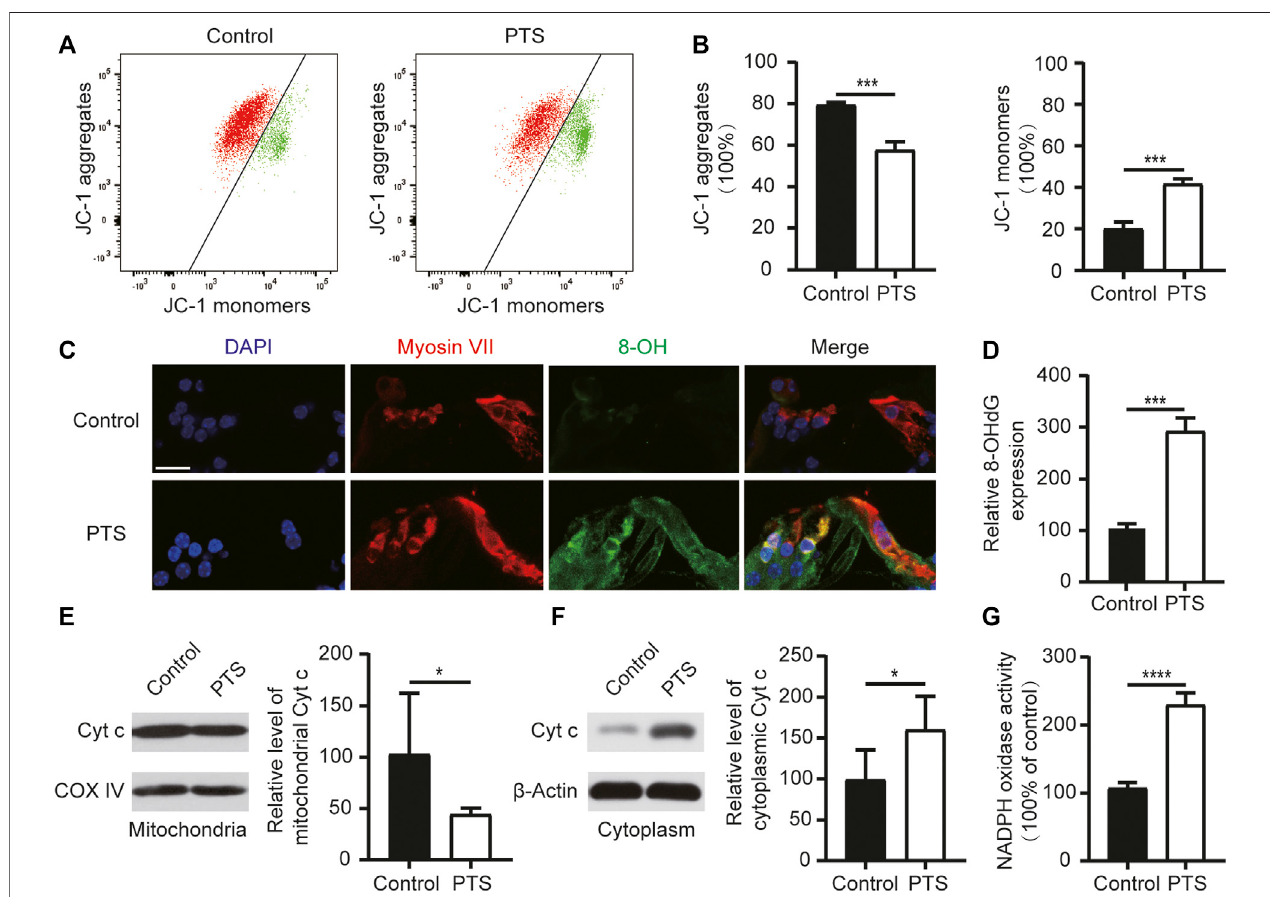
FIGURE 3 | Changes in mitochondrial membrane potential, ROS, apoptosis levels, and NADPH oxidase activity in the hair cells of mice in the PTS and control groups. (A) DetectionofmitochondrialmembranepotentialinthePTSandcontrolgroupsusing fl owcytometry. (B) RatioofJC-1aggregatesandJC-1monomers( n (cid:1) 3 pergroup). (C) Immunohistochemicalstainingoffrozensectionsofthecochleashowingchangesin8-OHexpressioninthePTSandcontrolgroups. (D) Quanti fi cationof 8-OH fl uorescenceintensity( n (cid:1) 5per group). (E) WB showingchangesinCytochromecexpression inthe mitochondria. (F) WB showing changesin Cytochrome c expression in the cell plasma ( n (cid:1) 6 per group). (G) Levels of NADPH oxidase activity in the different groups ( n (cid:1) 4 per group). ROS, reactive oxygen species; PTS, permanent threshold shift; WB, western blotting. * p < 0.05; *** p < 0.001; **** p < 0.0001. Scale bars: C, 20 μ m.